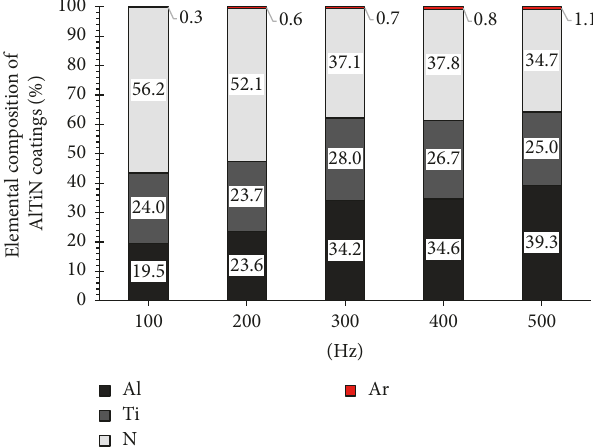
Figure4:ElementalcompositionofAlTiNcoatingsbyHPPMSwith various pulse-frequency in the range of 100–500